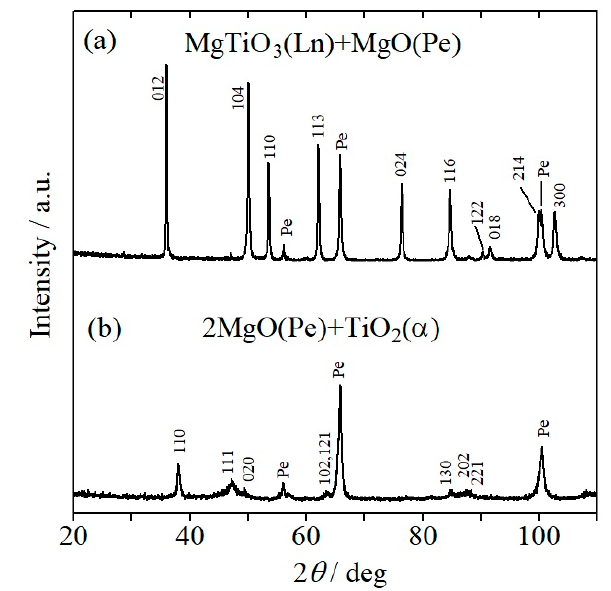
Figure 1. Powder X-ray diffraction patterns (Cr K α ) of run products of Mg 2 TiO 4 , ( a ) No. O161021 (21 GPa, 1600 °C) and ( b ) No. O160924 (28 GPa, 1300 °C). Miller indices in ( a ) are for Ln-type MgTiO 3 , and those in ( b ) are for α PbO 2 -type TiO 2 . Ln: LiNbO 3 -type, Pe: periclase, α : α PbO 2